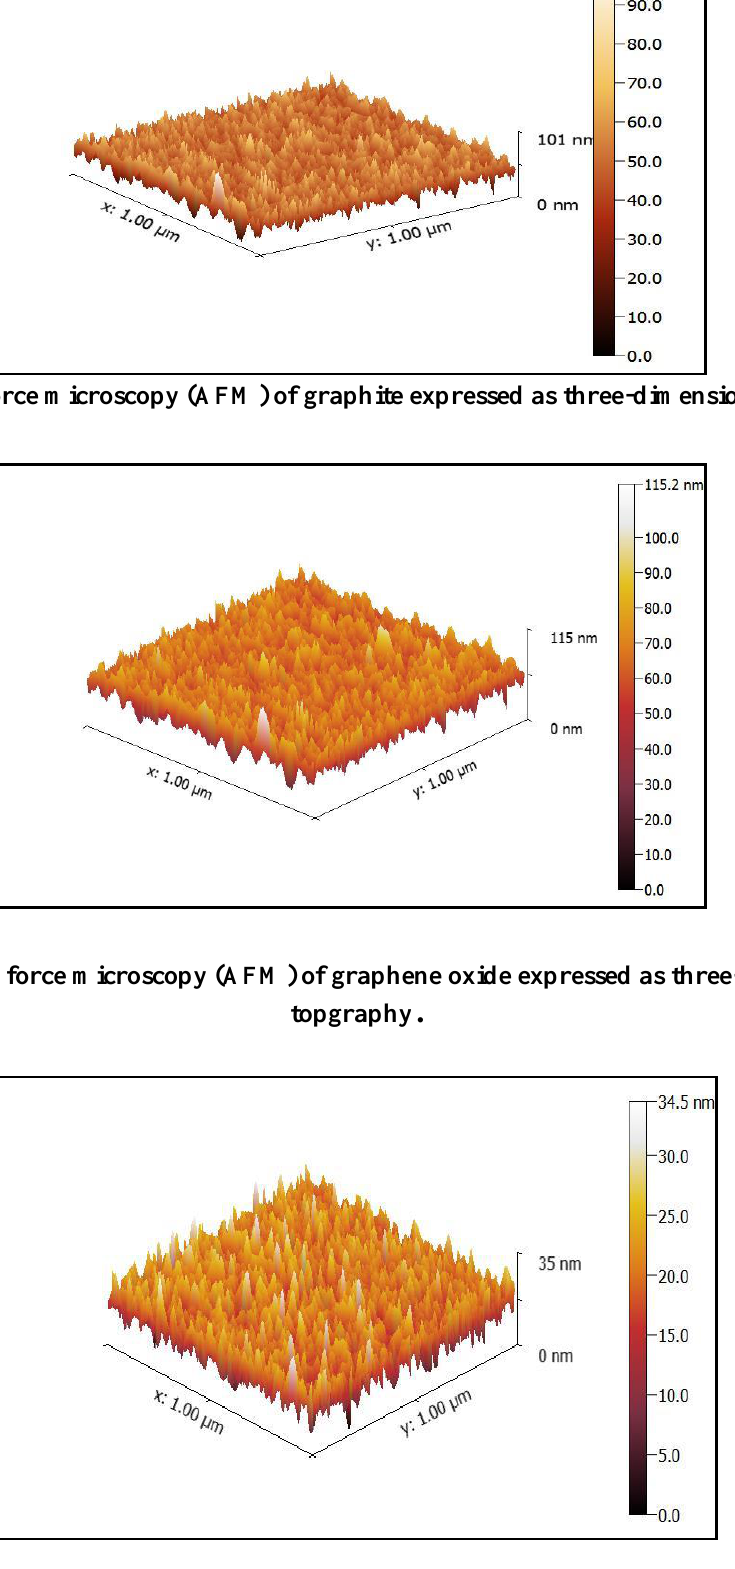
Fig. 6 . Atomic force microscopy (AFM) of coated sand expressed as the three-dimensional